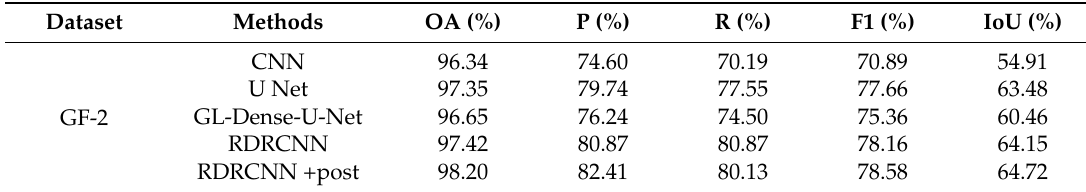
Table 8. Comparisons of the proposed and other deep-learning-based road extraction methods on the GF-2 road dataset in terms of better performance of